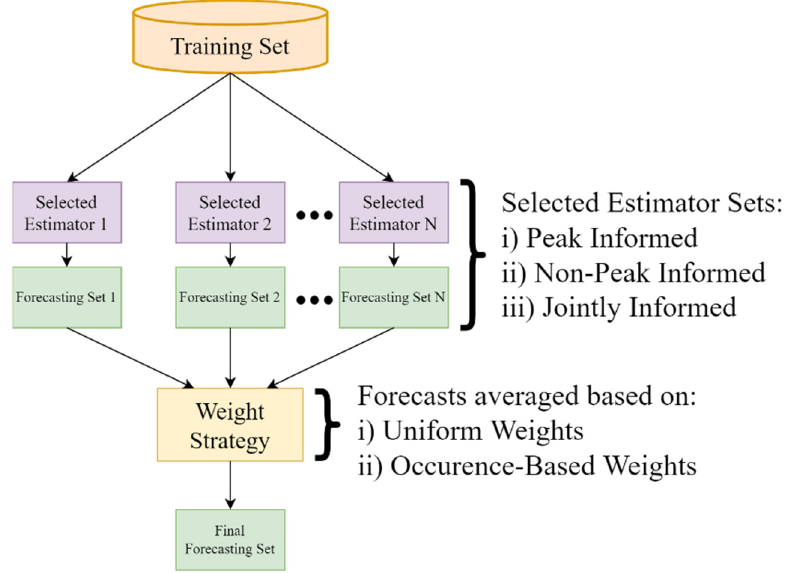
Figure 7. Voting ensemble structure based on the peak and non-peak member selection strategy.